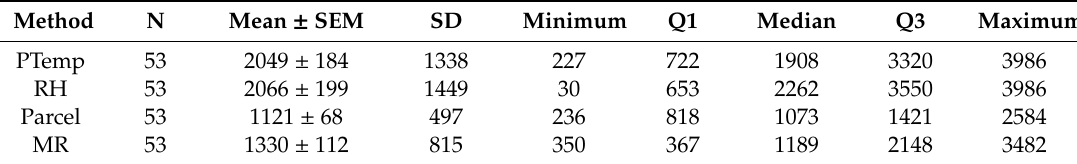
Table 1. The atmospheric boundary layer height (ABLH) values estimated using radiosonde data (PTemp, RH, and Parcel) and moderate resolution spectroradiometer (MODIS) data (MR). PTemp, RH, and MR are the potential temperature gradient, relative humidity gradient, and mixing ratio gradient methods, respectively. N is the number of samples; SEM is the standard error of the mean; SD is the standard deviation; Q1 is the first quartile value; and Q3 is the third quartile